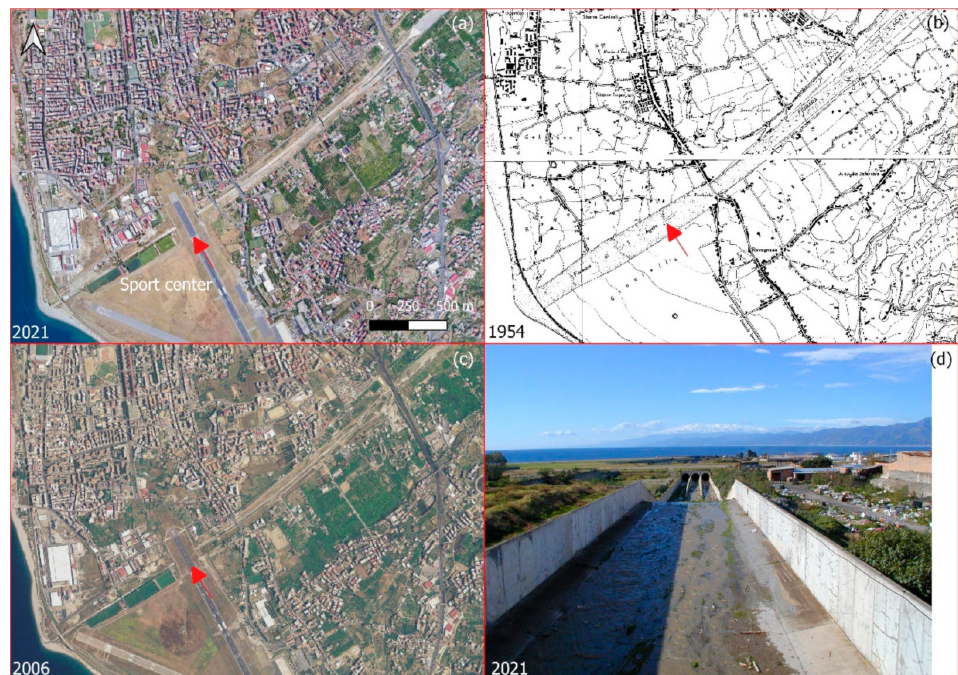
Figure 6. The Sant’Agata River. ( a ) An image from Google Earth from September 2021. ( b ) The CASMEZ cartography from 1954. ( c ) The orthophoto from 2006. ( d ) The view towards the mouth of the culvert below the airport runway. The arrows identify the point where the northern end of the airport runway has been extended.